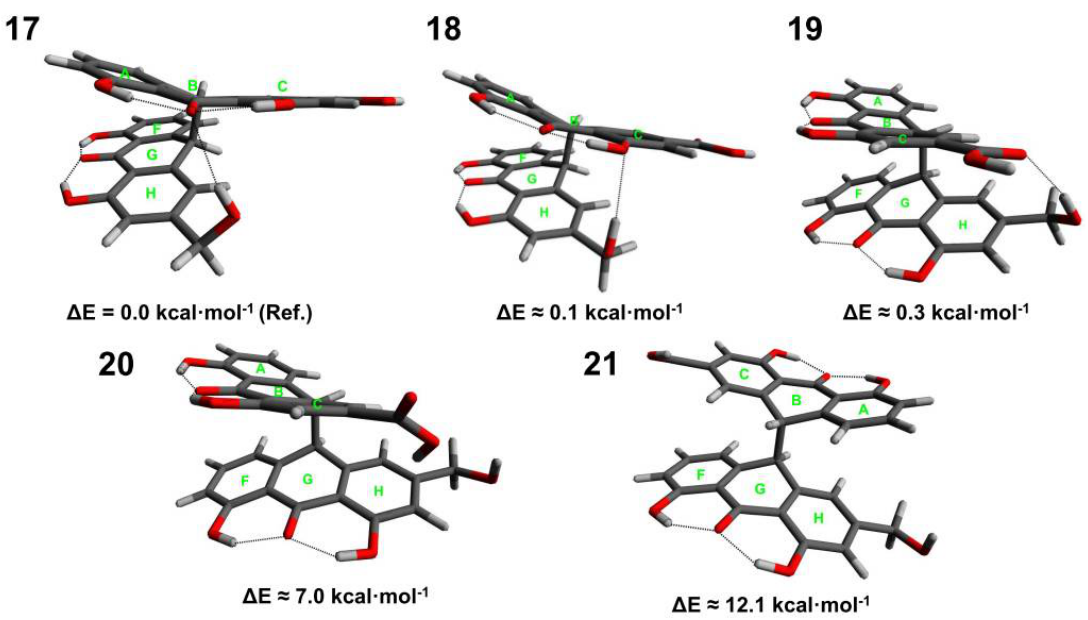
Figure 4. Conformers ( 17 – 21 ) of sennidin D.